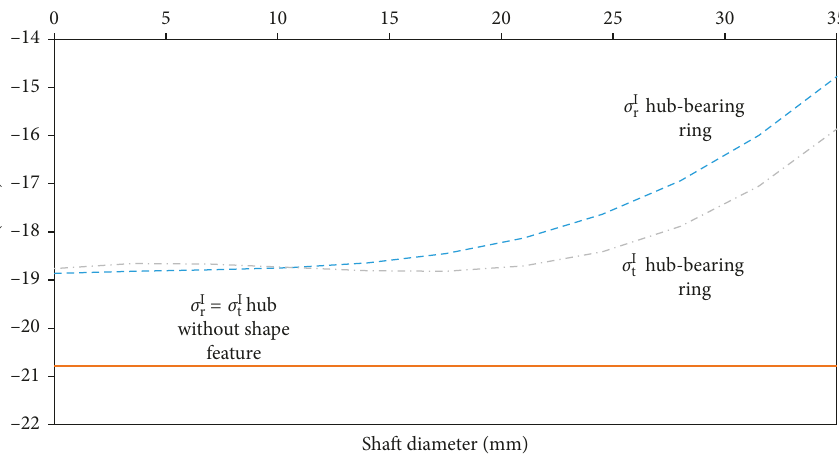
Figure 8: Radial and tangential stress (shaft)